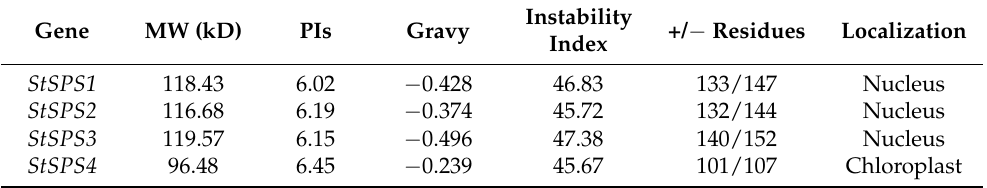
Table 3. Physicochemical properties and subcellular localization prediction of StSPS family proteins. MW: molecular weight. PIs: theoretical isoelectric points. Gravy represents the average hydrophilic coefficient. “+/ − “ represents